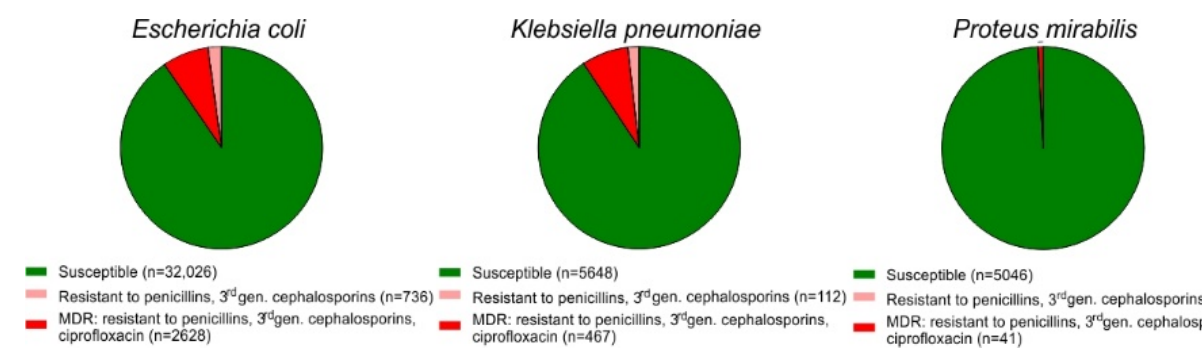
Figure 1. Incidence of resistance in 35,390 E. coli , 6227 K. pneumoniae , and 5088 P. mirabilis urine strains isolated in 2018 (green, susceptible; red, MDR, i.e., resistant against penicillins, 3rd generation cephalosporins and ciprofloxacin; light red, resistant against penicillins and 3rd generation cephalosporins).